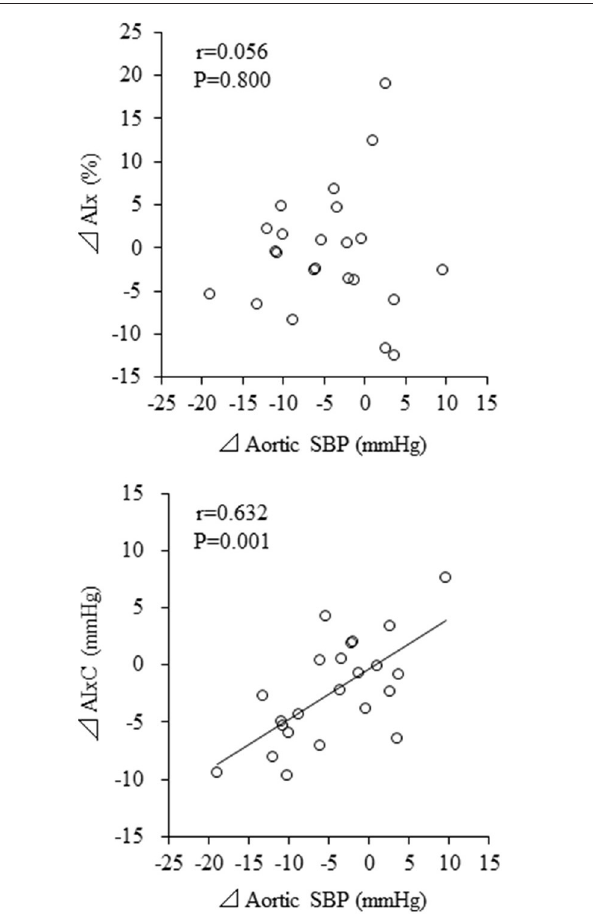
FIGURE 5 | Correlations between changes in augmentation index (AIx) and aortic systolic blood pressure (SBP). AIxC, AIx-associated companion